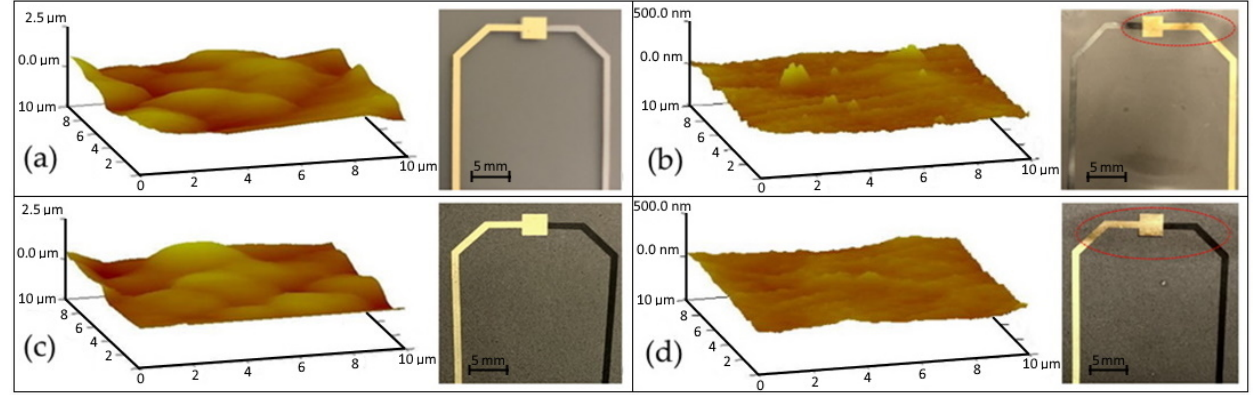
Figure 4. PVDF films and their surface topology: ( a ) pristine unpressed; ( b ) pristine hot pressed; ( c ) rGO doped unpressed; ( d ) rGO doped hot-pressed films. Note the hot-press-induced optical transparency annotated in red for ( b , d ).